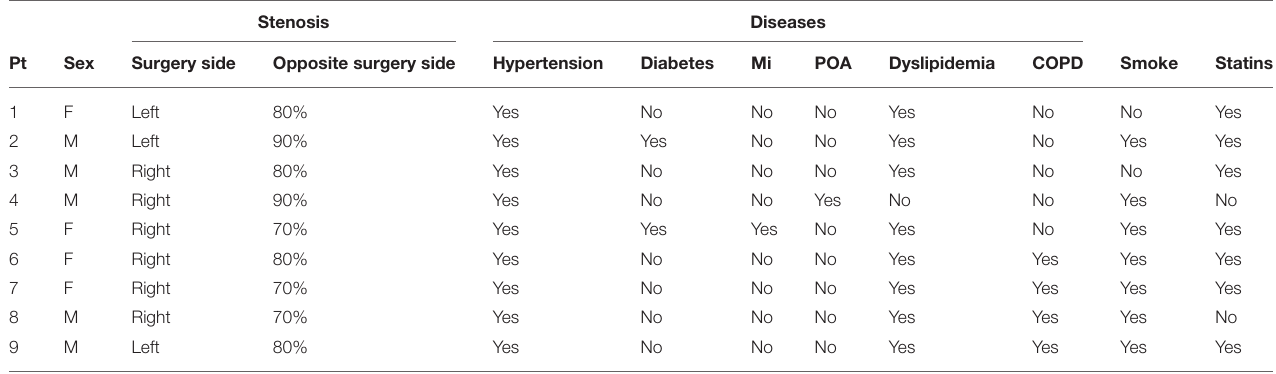
TABLE 1 | Characteristics of all carotid endarterectomy (CEA) patients included in the study ( n = 9). Stenosis Diseases Surgery side Opposite surgery side Hypertension